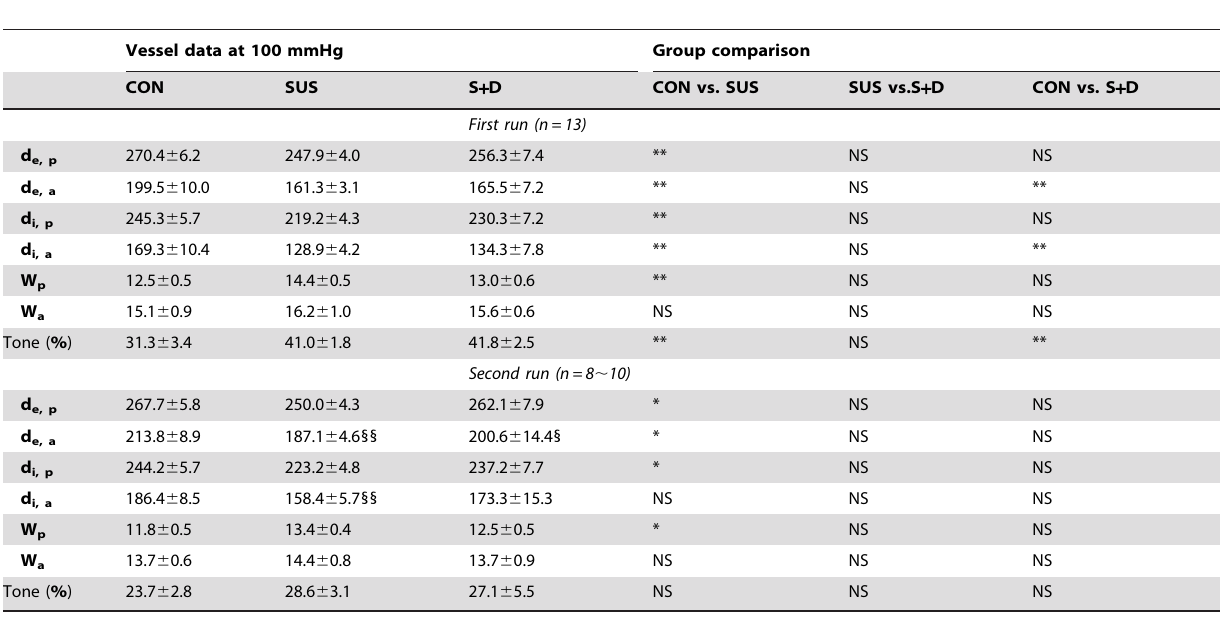
Table 2. Dimensions of segments of middle cerebral arteries isolated from CON, SUS, and S + D rats (unit: m m).